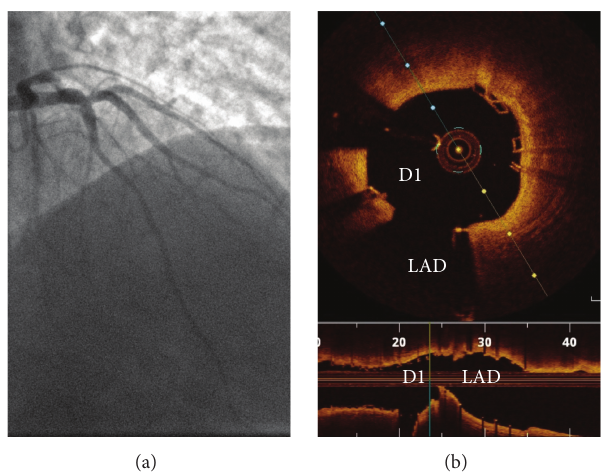
Figure 2: (a) Final angiographic result. (b) Final optical coherence tomography (OCT) from the distal side branch to proximal main branch. Cross section shows the carina with the left anterior descending artery (LAD) and the first diagonal (D1) with the scaffold well apposed.